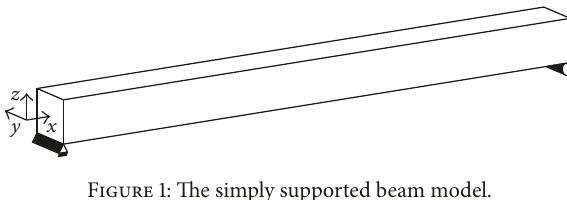
Figure 1: The simply supported beam